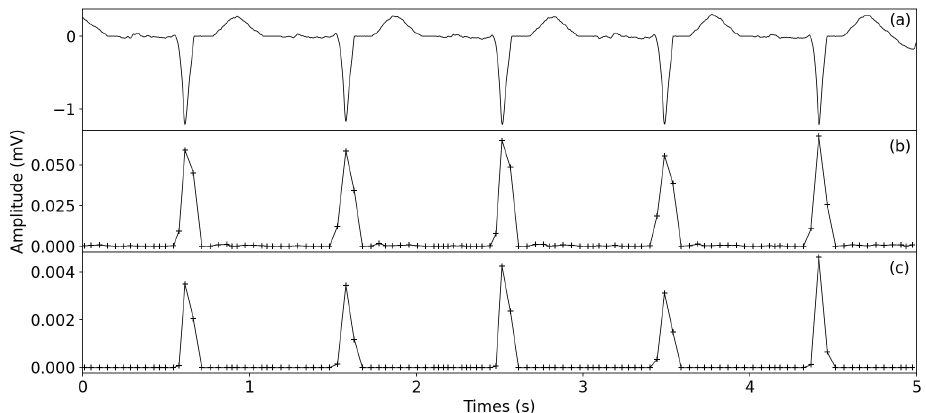
Figure 4. Comparison of original signal and the transformed signals, ( a ) Original signal of 207 from MIT-BIH database. ( b ) WVT—window variance transform signal. ( c ) SWVT—squared window variance transform